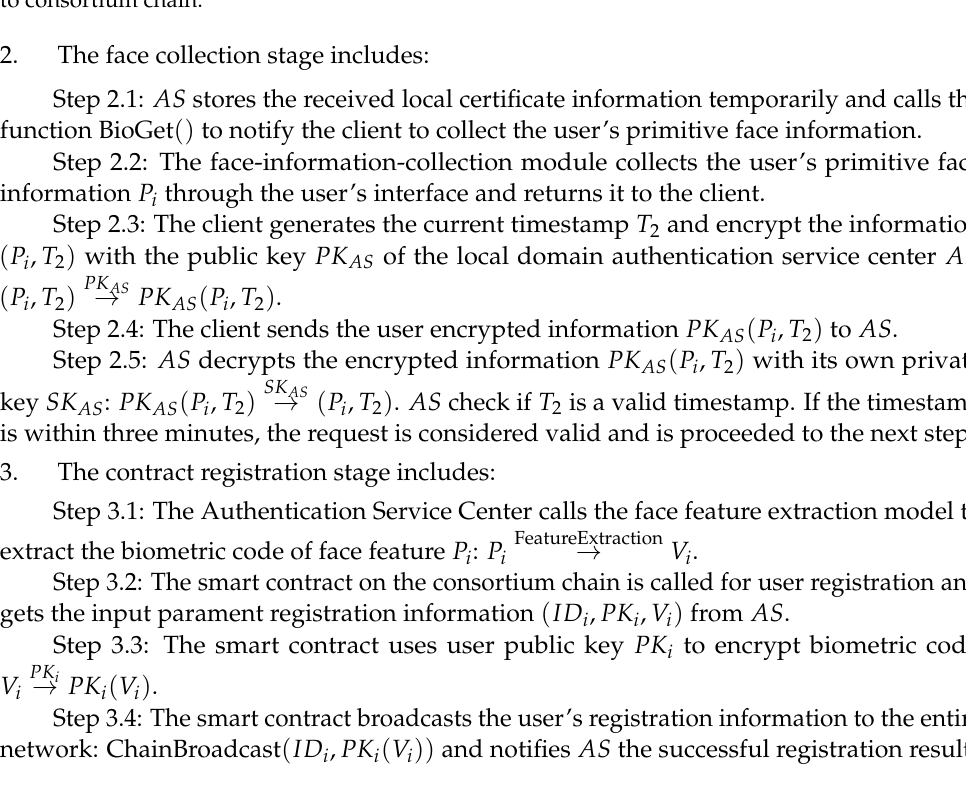
Figure 5. Registration process of local domain. The user sends the registration information to the AS node through the client. As invokes CA to assign a certificate according to registration information, then notifies user to input face information, and finally writes registration information to consortium